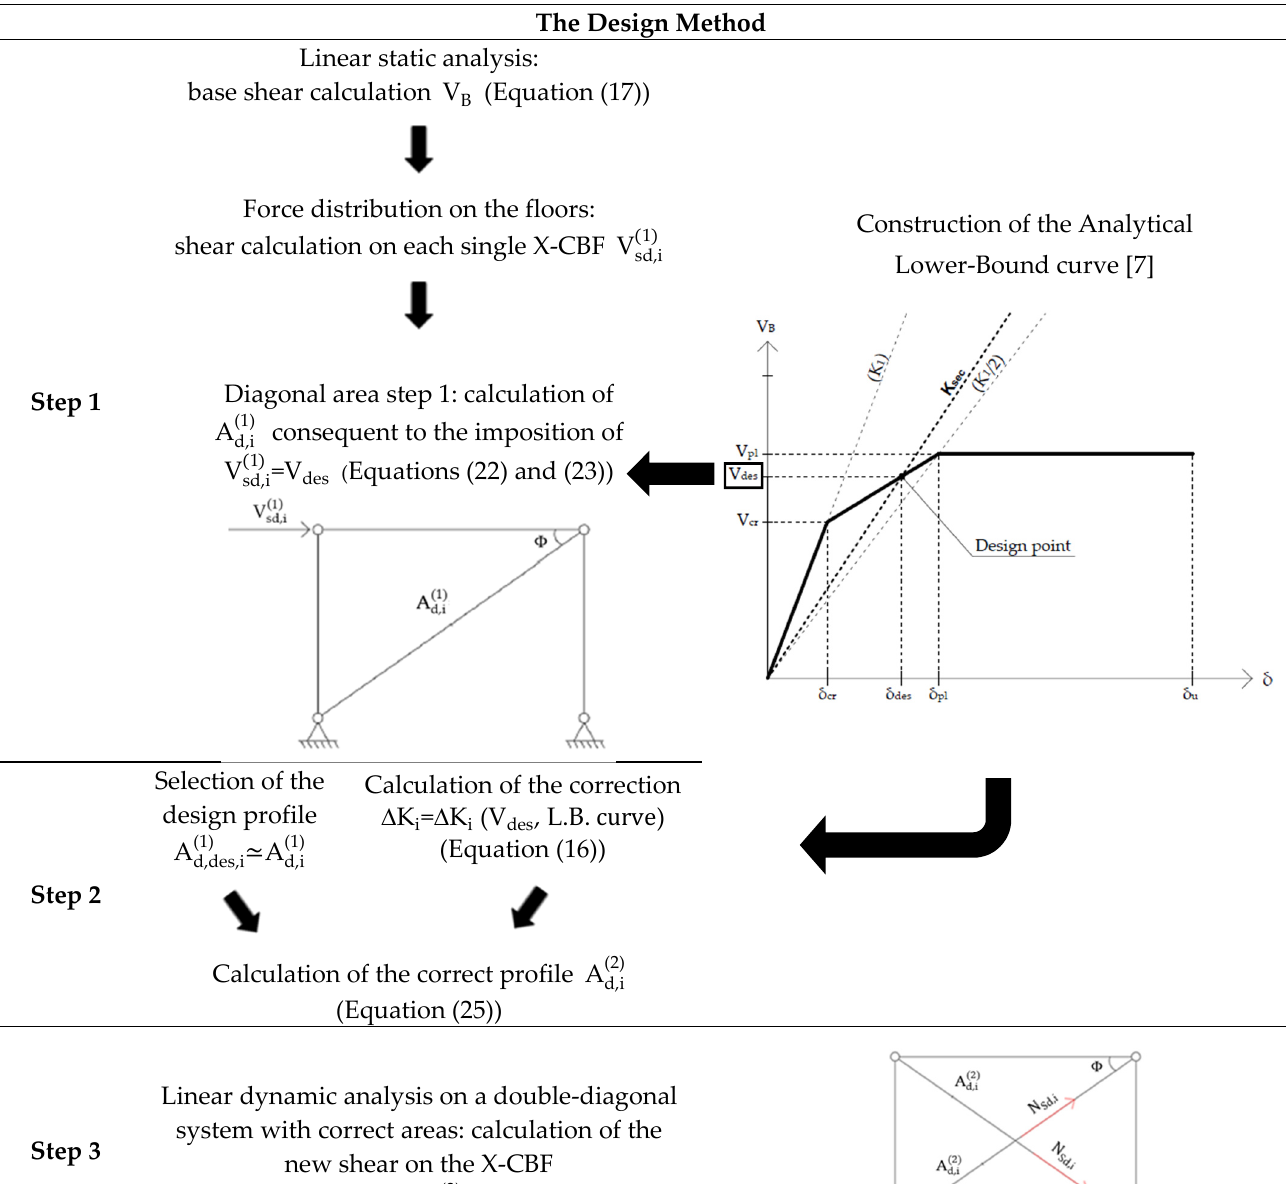
Table 1. Summary of the proposed design method.